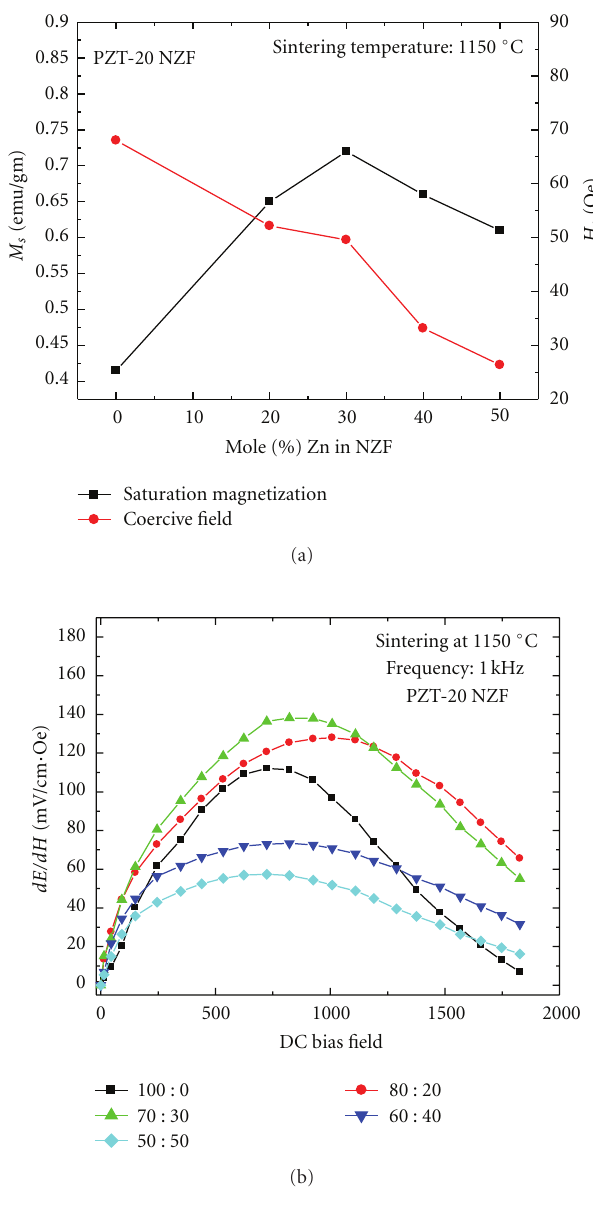
Figure 6: E ff ect of Zn doping on magnetic and magnetoelectric properties of PZT-20